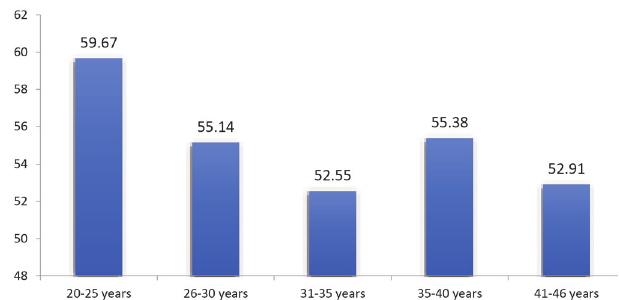
Figure 1. Mean Stay (Days) on Extreme-Altitude in Comparison to Age (Vertical axis depicts the number of